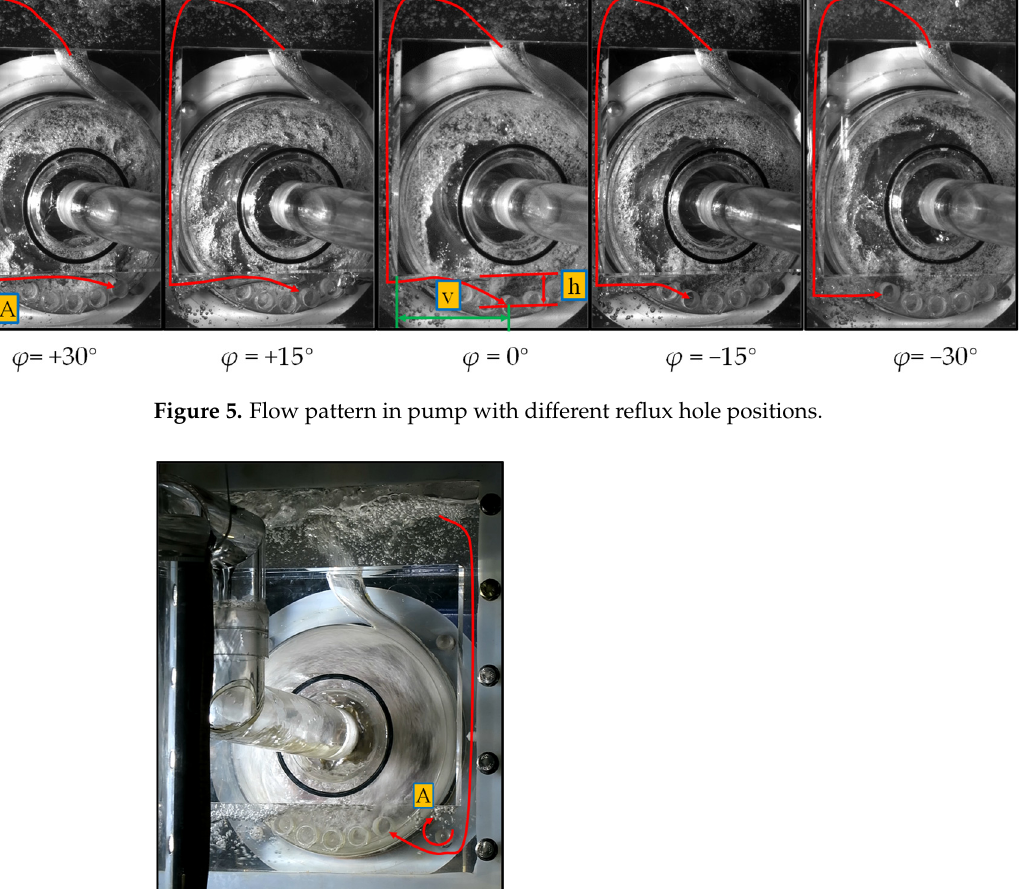
Figure 5. Flow pattern in pump with different reflux hole positions.